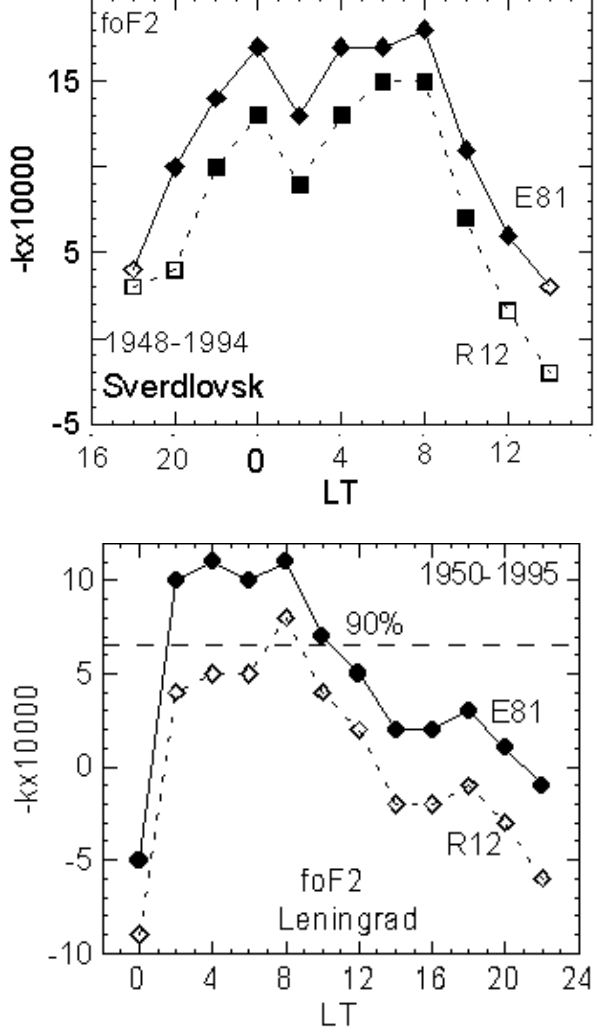
Fig. 1. Relative trends of fo F2 for the Sverdlovsk (top) and Leningrad (bottom) stations derived using the R12 and E81 indices. The closed and open symbols in the top panel correspond to the sta- tistical significance above and below 90% according to the Fisher criterion. The horizontal line in the bottom panel shows approx- imately the k value for the significance of 90% according to the Fisher